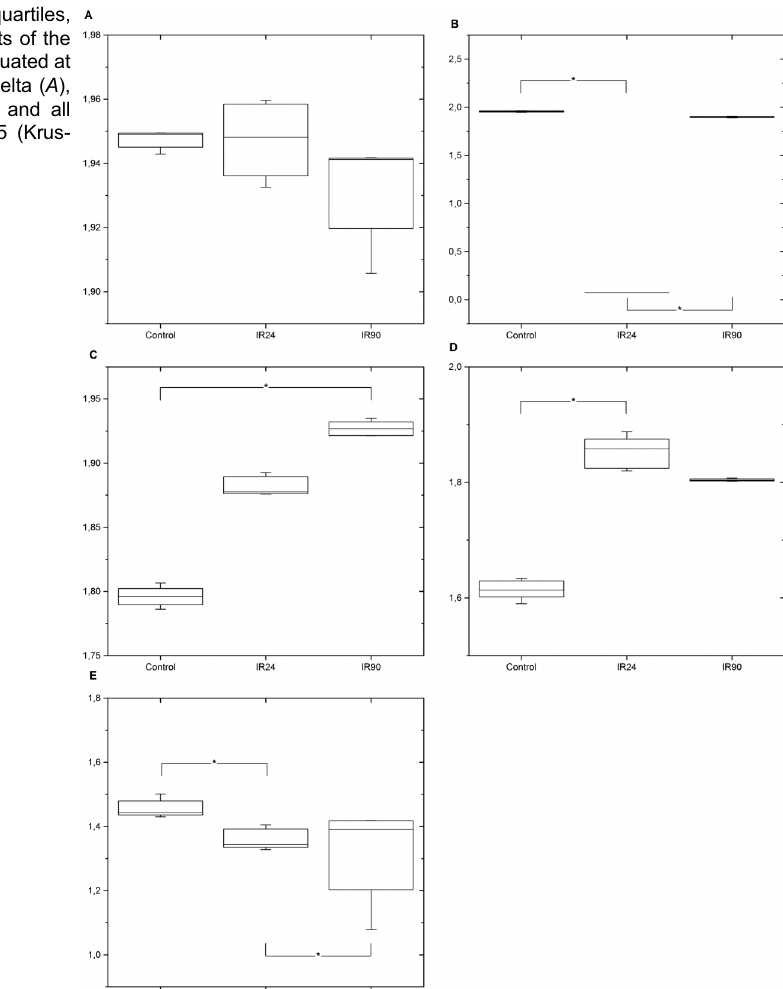
Figure 5. Box plot (median, 1st and 3rd quartiles, maximum and minimum) showing the results of the a -DFA for the groups control, irradiation evaluated at 24 h (IR24) and at 90 days (IR90) for the delta ( A ), theta ( B ), alpha ( C ) and beta ( D ) waves, and all electrocorticogram recordings ( E ). *P o 0.05 (Krus- kal-Wallis nonparametric